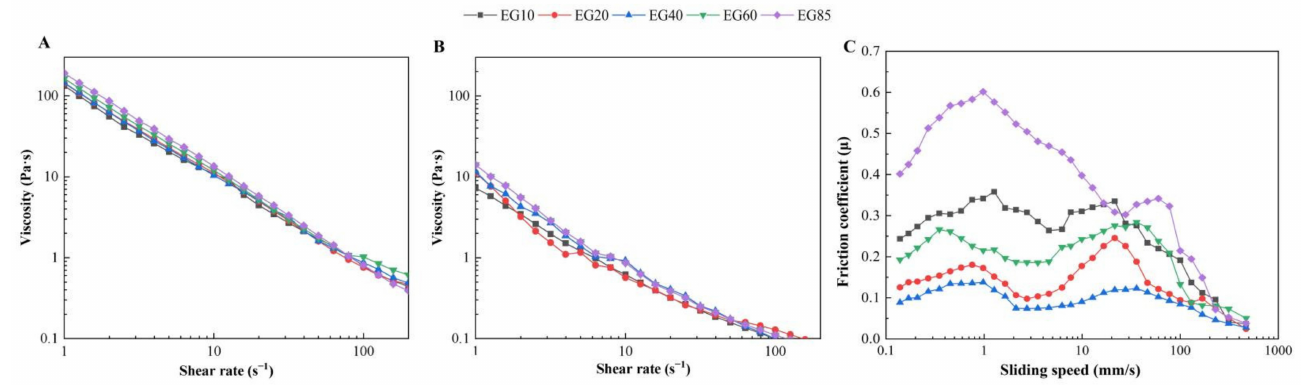
Figure 5. Rheological curves of acid milk gels ( A ) before and ( B ) after simulated oral processing. ( C ) Tribological curves of acid milk gels after simulated oral